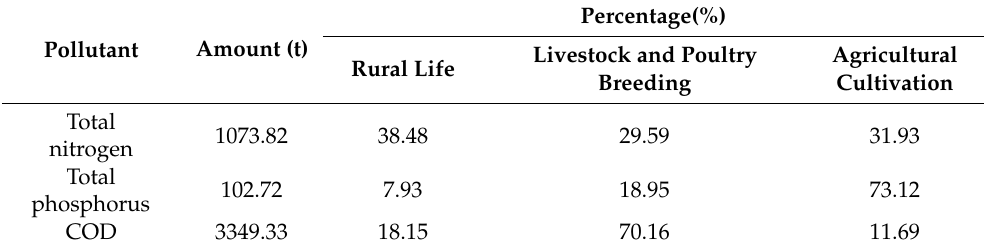
Table 1. Non-point source loads in agricultural and rural